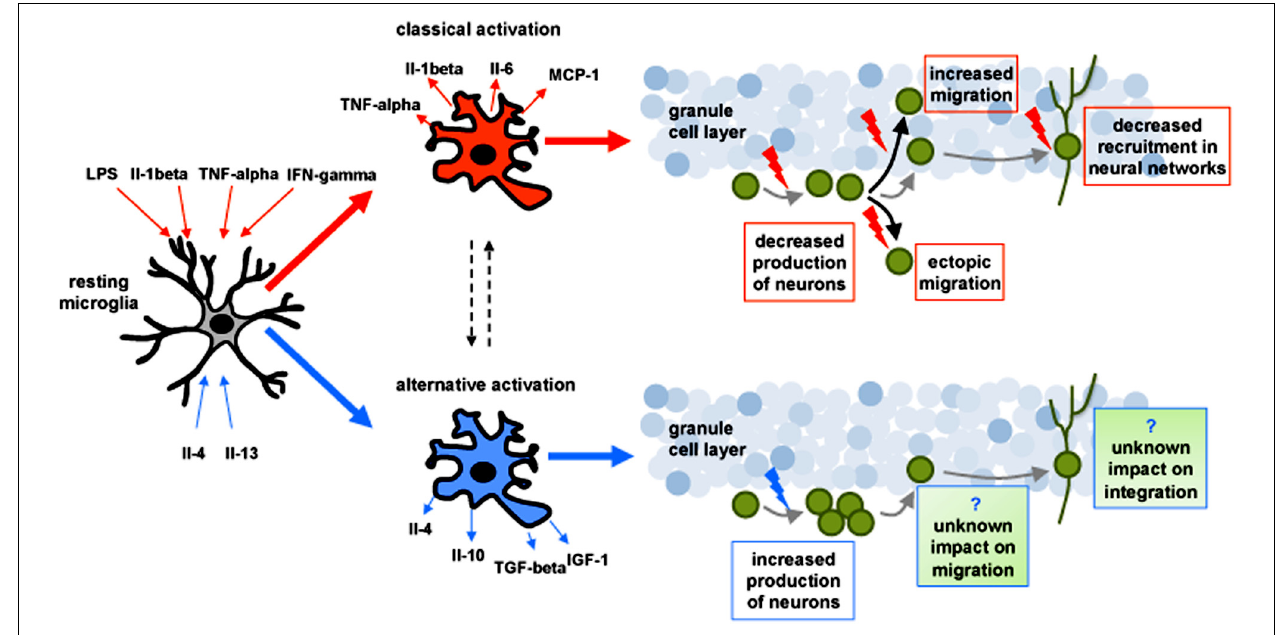
(IFN)-gamma, tumor necrosis factor (TNF)-alpha and interleukin (Il)-1beta, as well as bacterial-derived LPS. Classically activated microglia has been shown to: (1) decrease the production of neurons, (2) alter their migration pattern, and (3) reduce their recruitment into neuronal networks (red arrows). Alternative activation of microglia can be induced experimentally by anti-inflammatory cytokines such as Il-4 and Il-13 and can increase the production of neurons (blue arrow).The impact of alternative activation of microglia on the migration and the integration of new neurons remains